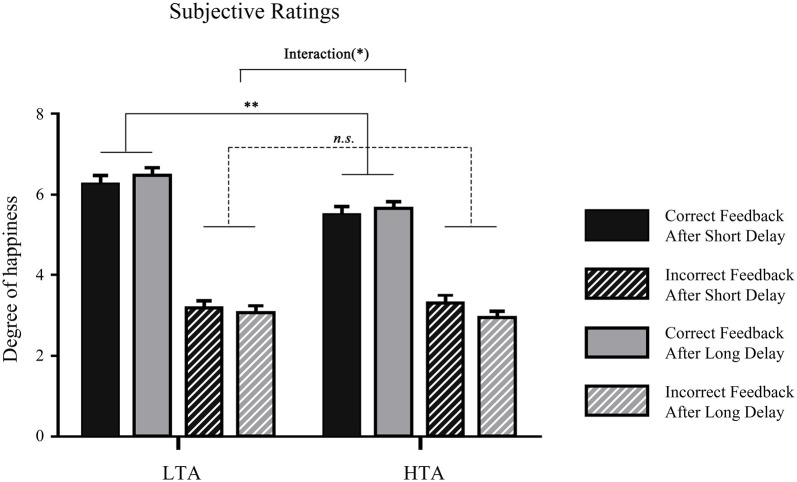
Mean degree of happiness in each waiting time condition in the two groups. **p < 0.01, *p < 0.05.